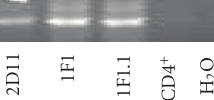
Figure 6: Expression of V α 14 J α 281 on iNKT cells. Mouse iNKT cells express a TCR αβ that utilizes invariant V α 14 and J α 281 gene segments. RT-PCR using specific primers showed that lines 1F1, 1F1.1 subderived line of 1F1 and 2D11, all expressed V α 14J α 281 region, whereas a standard CD4 + T cell clone was negative for this expression. The 443bp amplicon was separated on a 2% agarose gel.